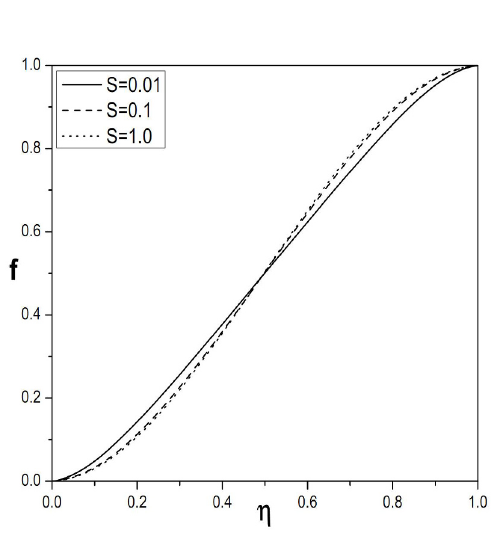
Figure 2. Effect of S on normal velocity at Re